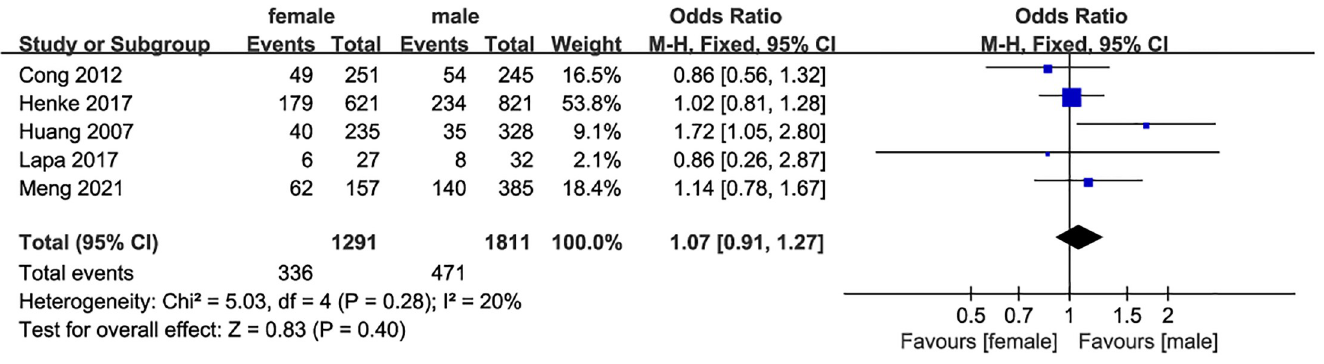
Fig 3. Forest plot for the relationship between gender and dysphagia after